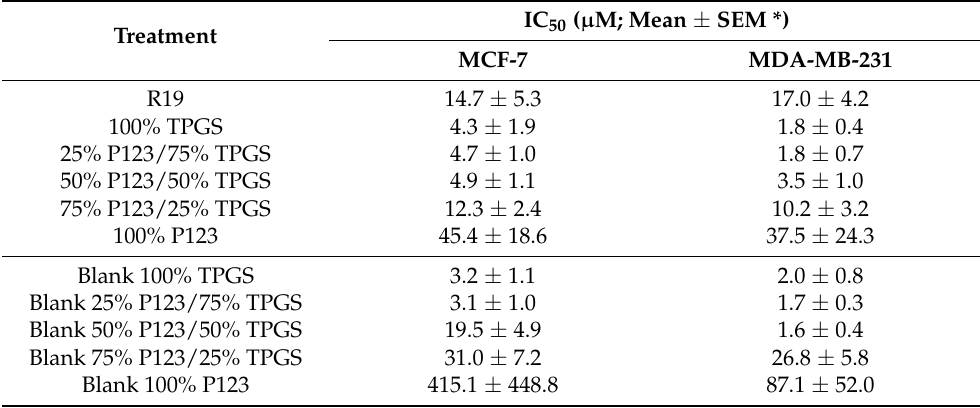
Figure 9. Percentage viability of MDA-MB-231 cells treated with ( A ) R19 and R19-loaded NPs and ( B ) blank NPs for 48 h ( n = 5). Table 4. IC 50 values of R19 and R19-loaded NPs and equivalent concentrations of blank NPs in MCF-7 and MDA-MB-231 cells after 48 h of incubation.